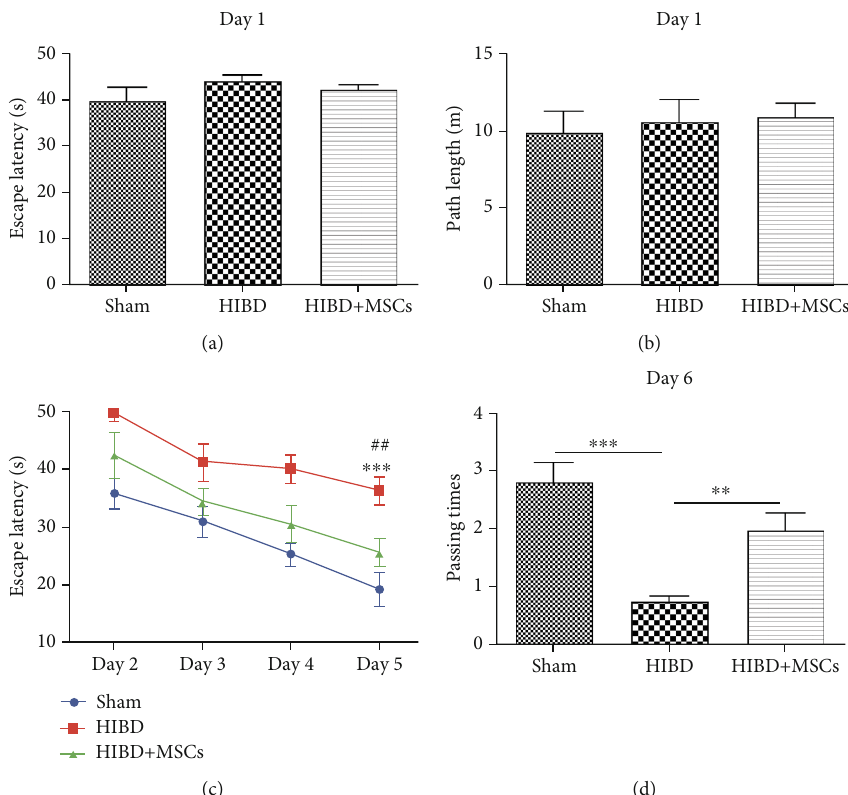
Figure 2: MSC transplantation improved the spatial learning-memory function of HIBD rats. (a, b) Escape latencies and path lengths to reach the visible platform for the sham, HIBD, and HIBD+MSC rats on the 1 st day of the MWM test. (c) Escape latencies of each group to locate the invisible platform from the 2 nd to the 5 th day in the MWM test ( n = 10 , ∗∗∗ P < 0 : 001 vs. the sham group; ## P < 0 : 01 vs. the HIBD+MSC group). (d) Number of times passing through the former platform region for each group on the 6 th day of the MWM test ( n = 10 , ∗∗∗ P < 0 : 001 vs. the sham group; ∗∗ P < 0 : 01 vs. the HIBD+MSC